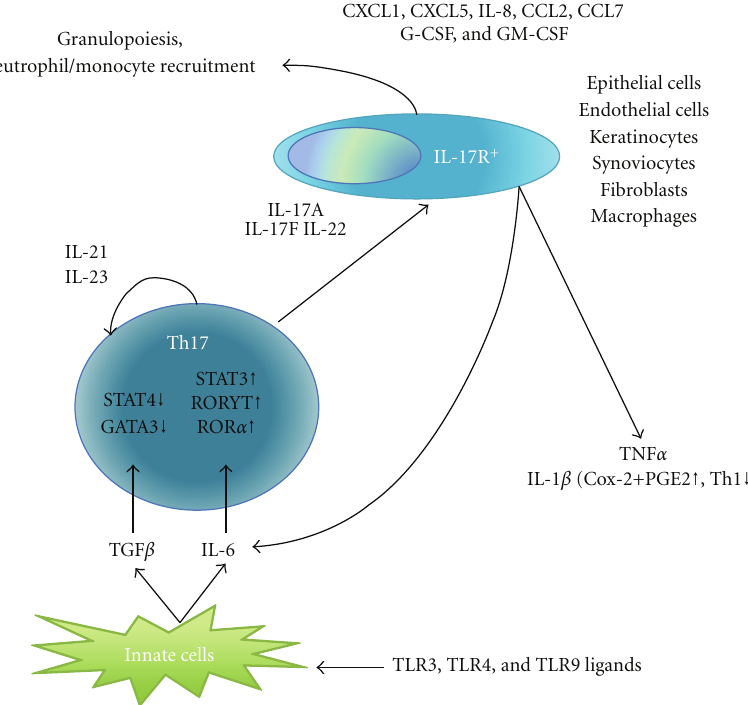
Figure 1: Implications of Th17 di ff erentiation in the development of the immune